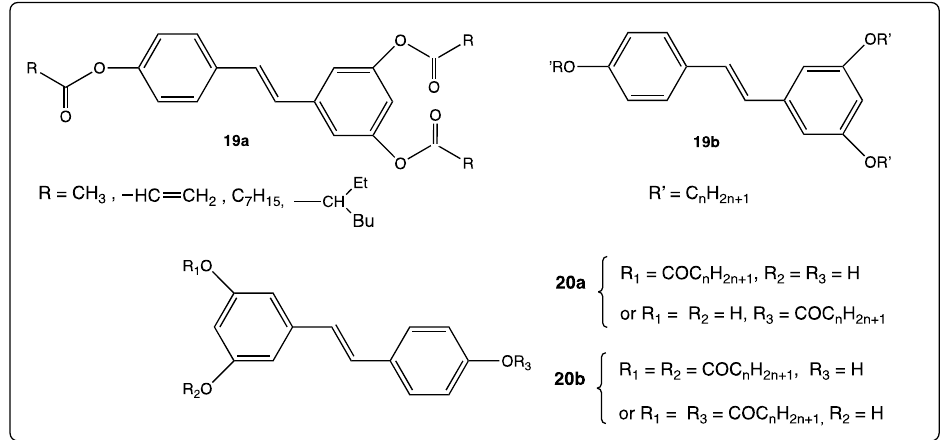
Figure 10 . Structure of mono, di, tri ethers and esters 19a – b and 20a – b. Figure 10. Structure of mono, di, tri ethers and esters 19a – b and 20a – b